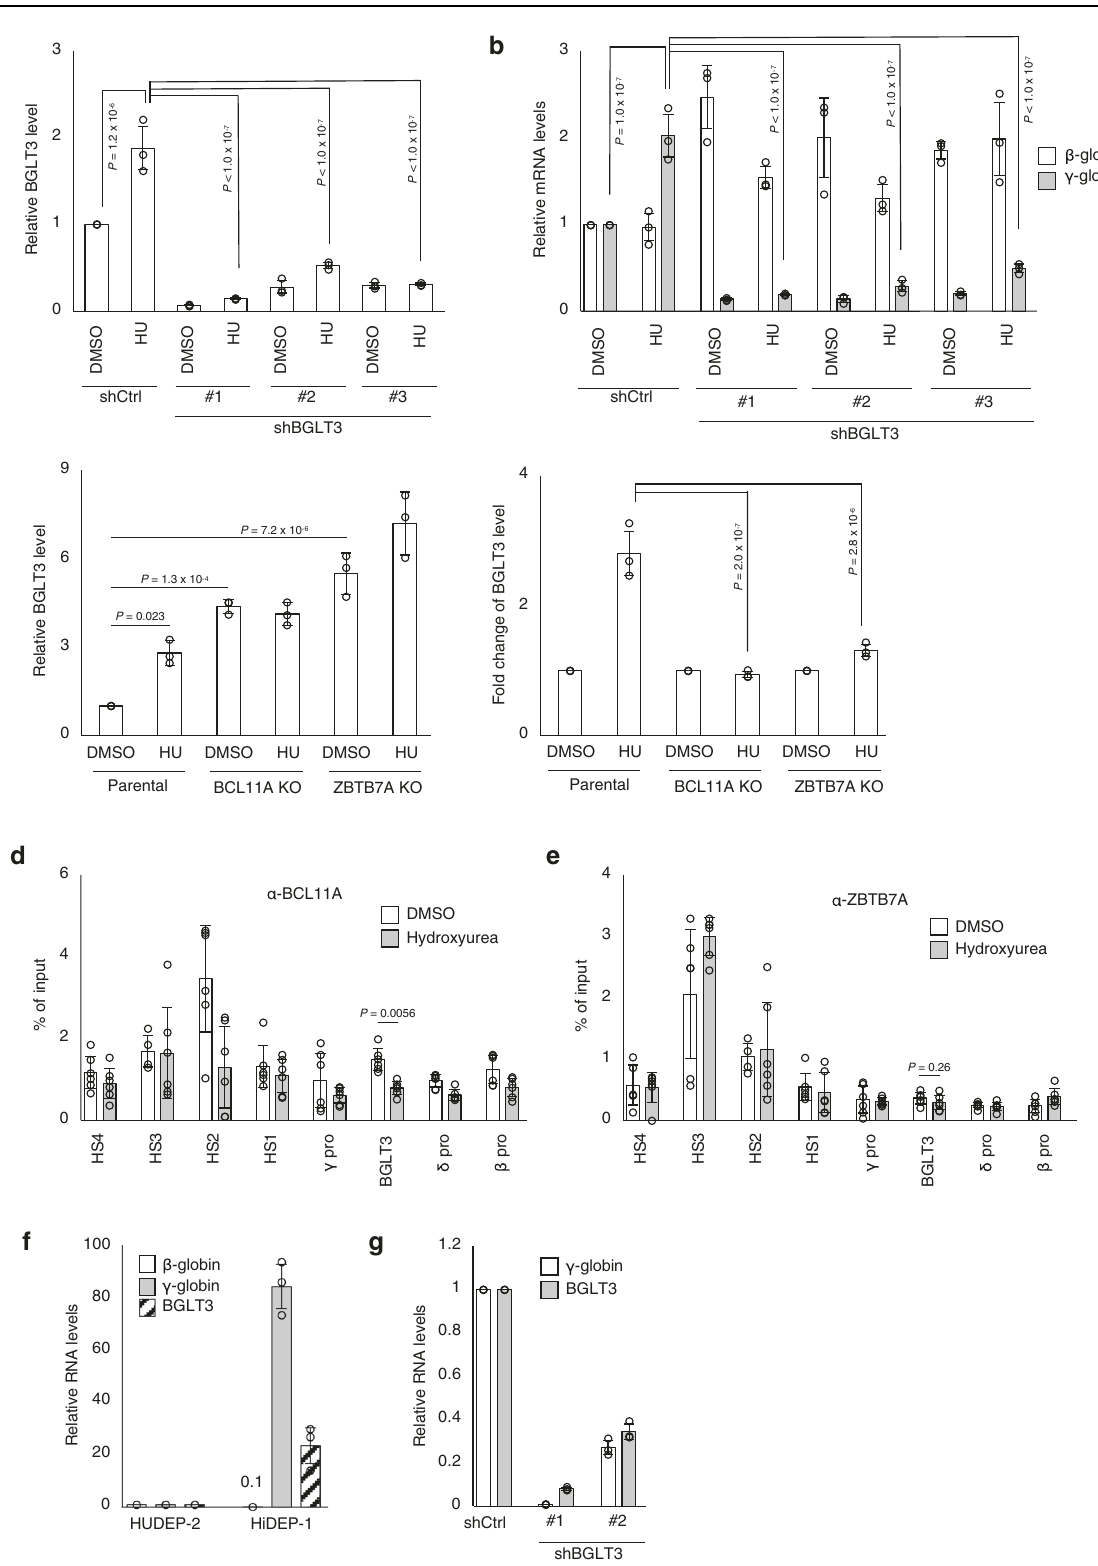
development has shown that both BGLT3 and γ -globin are co- expressed during the fetal stage 10 . In primates, simians have highly conserved homologs with sequence homology to the human BGLT3 gene, but this is not the case for other mammals such as prosimians (Supplementary Fig. 13). Simians have γ -globins that are expressed during the fetal stage, whereas prosimians and other species do